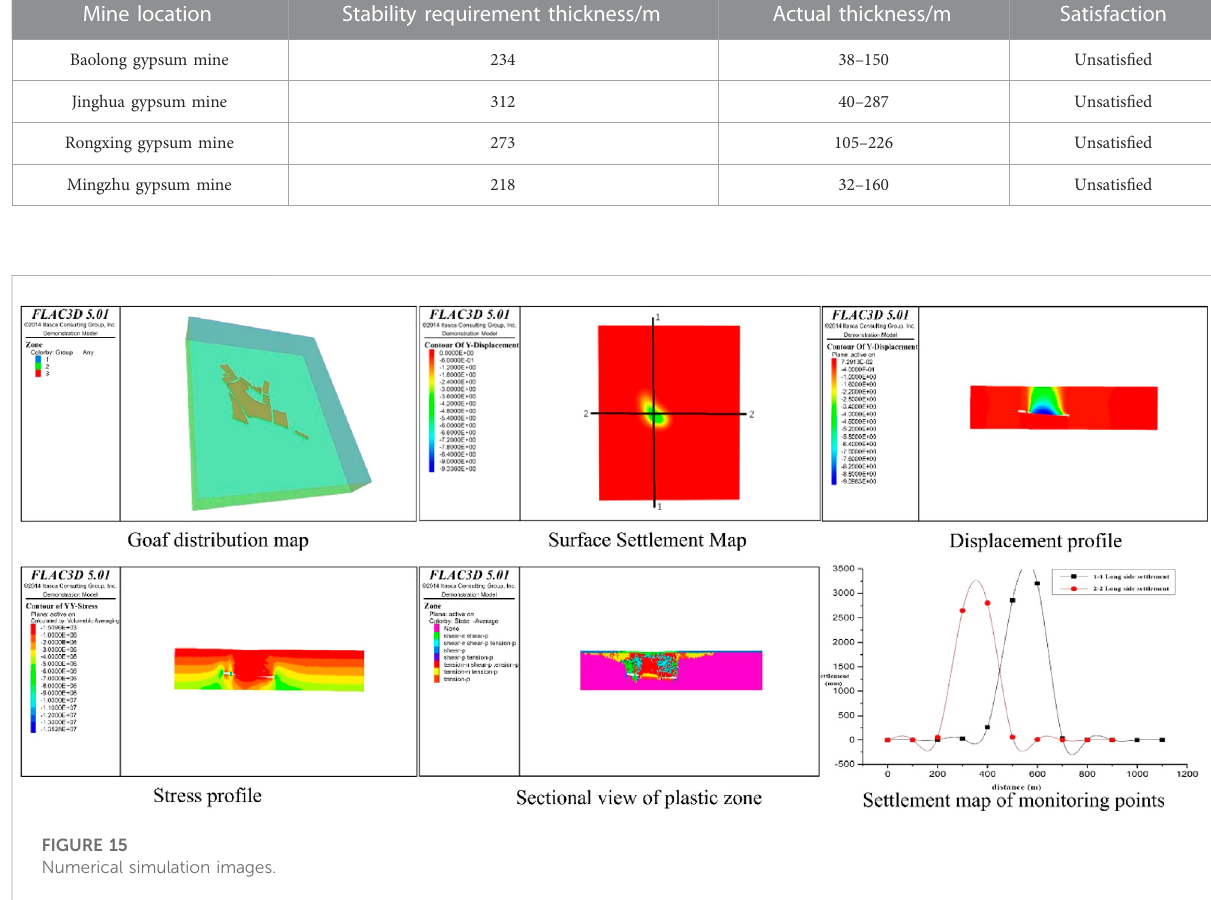
FIGURE 15 Numerical simulation